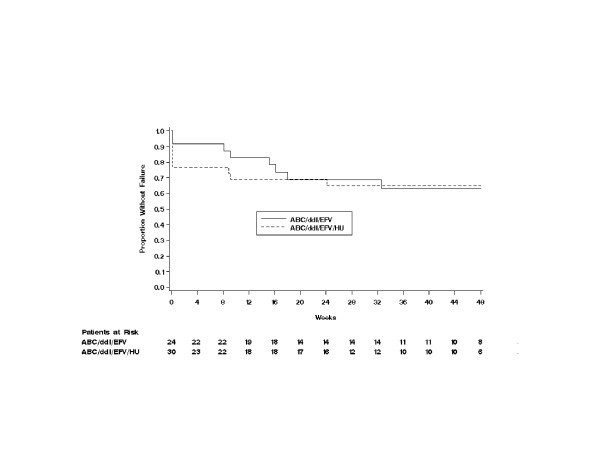
Time to virologic failure. ABC = abacavir; ddI = didanosine; EFV = efavirenz; HU = hydroxyurea. Virologic failure was defined by any of the following: HIV-1 RNA >400 copies/mL by week 24, repeated detection (>400 copies/mL) after initial suppression to undetectable levels (<400 copies/mL) or a 3-fold or greater increase in plasma HIV-1 RNA level from the nadir at week 8 or later.